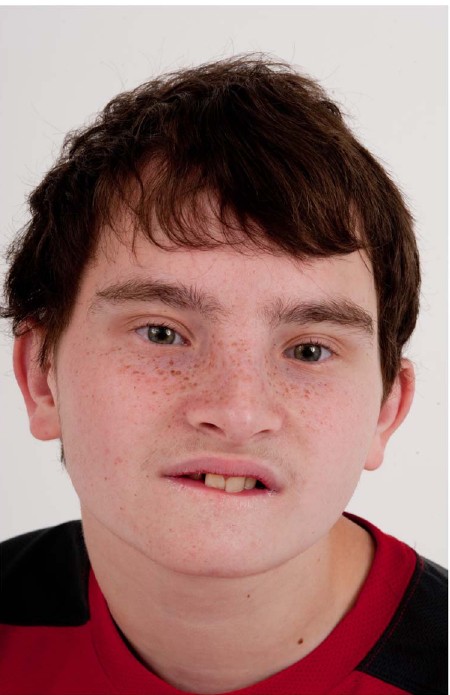
Figure 4. Profile view of Patient 3 at age 15 years. Dysmorphic features include low set ears.